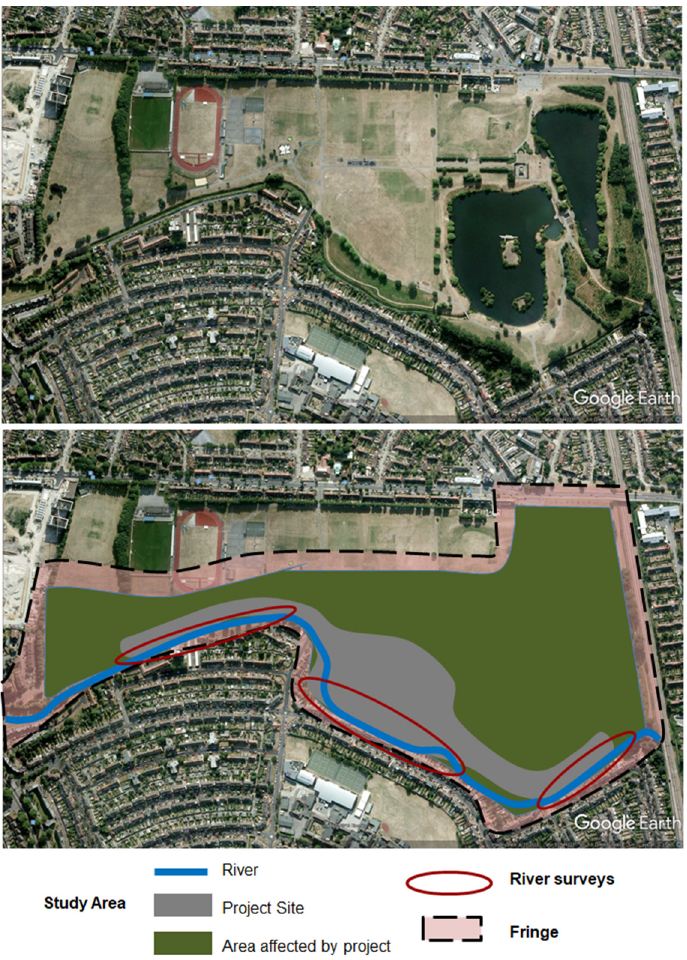
Figure 2. The spatial components of the PlaceMarker Survey. Image obtained from Google Earth, Image © 2018 Bluesky.